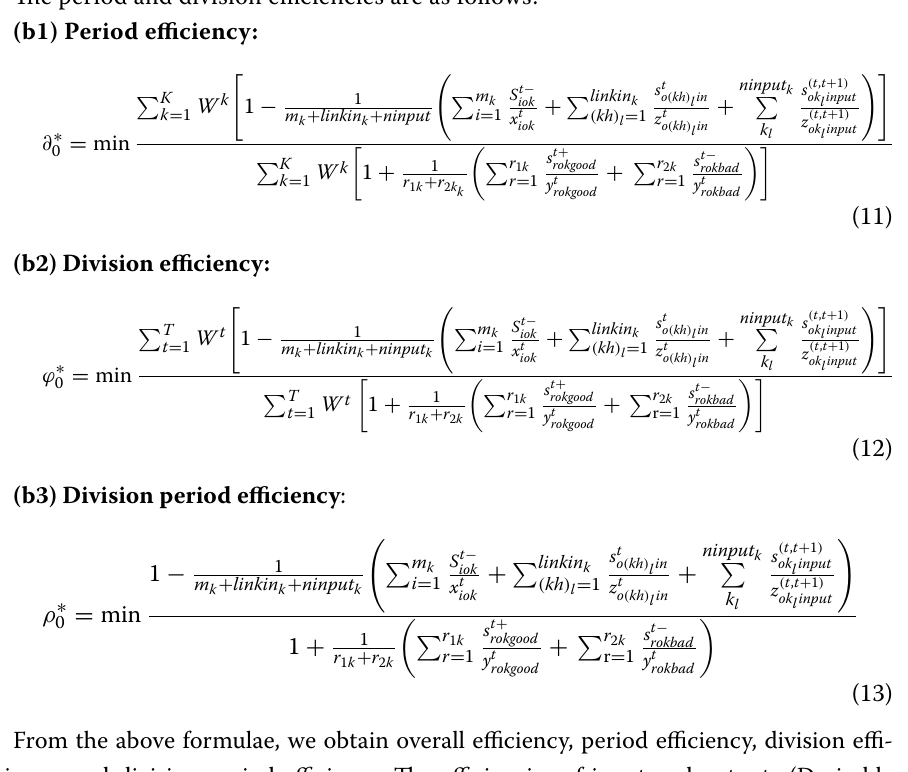
Input efficiency Desirable output efficiency